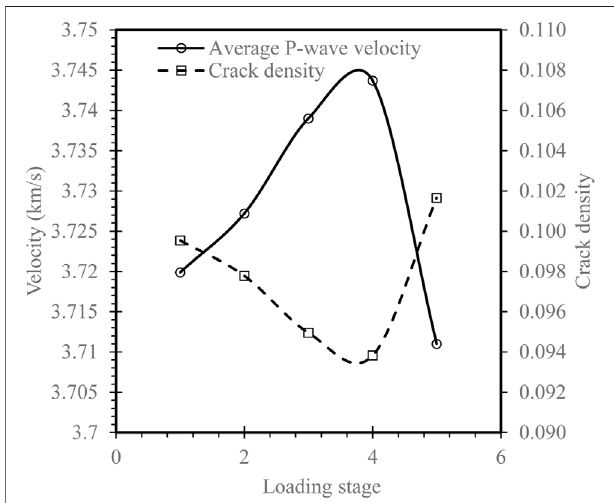
FIGURE 12 | Changes of the average velocity and the inverted crack density through Plane z (cid:1) 50 mm in the uniaxial compression test.